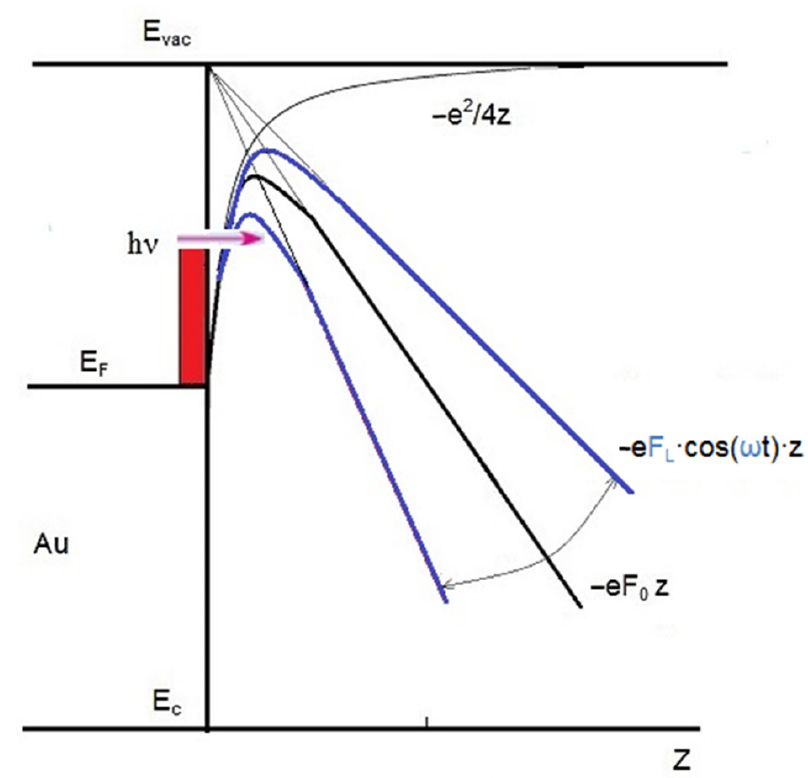
Figure 8. Scheme of energy levels near the GNS surface and the form of a potential barrier in a strong electrostatic field F 0 and an oscillating laser field F L with allowance for the Schottky effect for field and photoemission of hot electrons with energy h ν